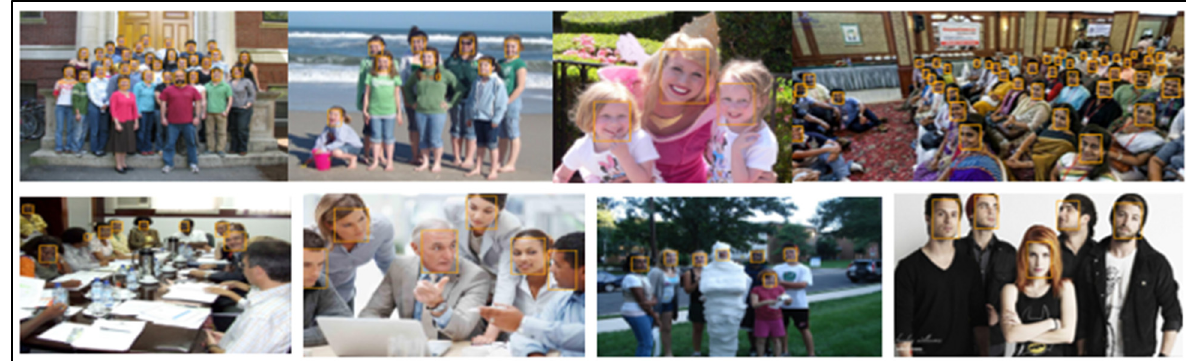
Figure 5. Occlusion image results (WIDER FACE dataset).